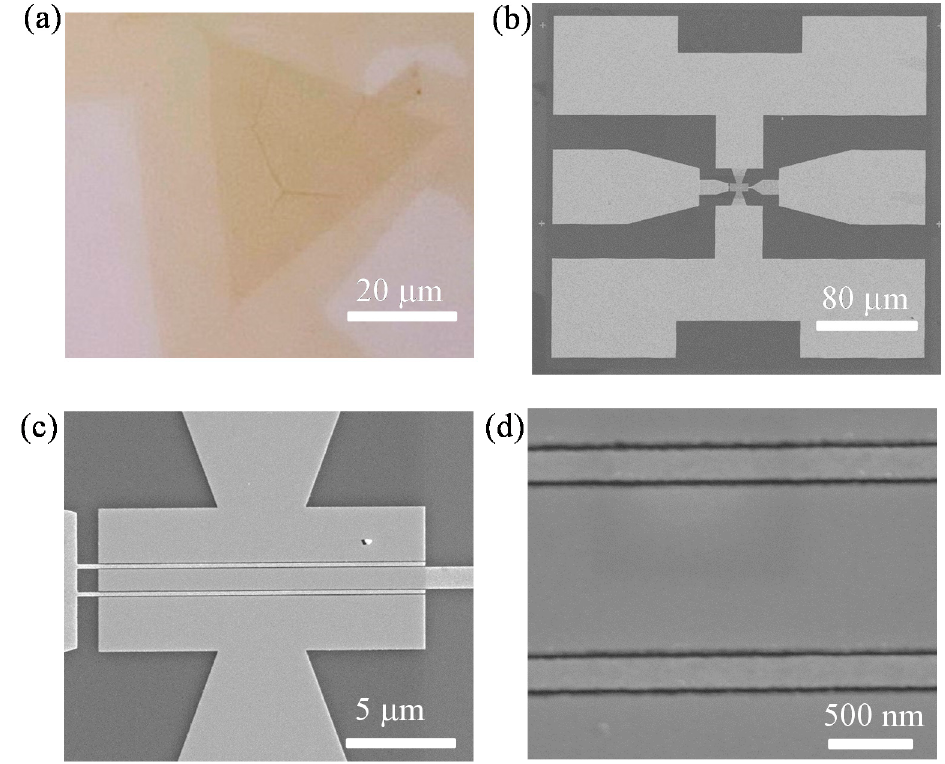
Figure 2. ( a ) The transferred bilayer MoS 2 on HfLaO/Si substrates. ( b – d ) SEM images of the 190 nm MoS 2 RF transistor with two-fingers structure showing excellent